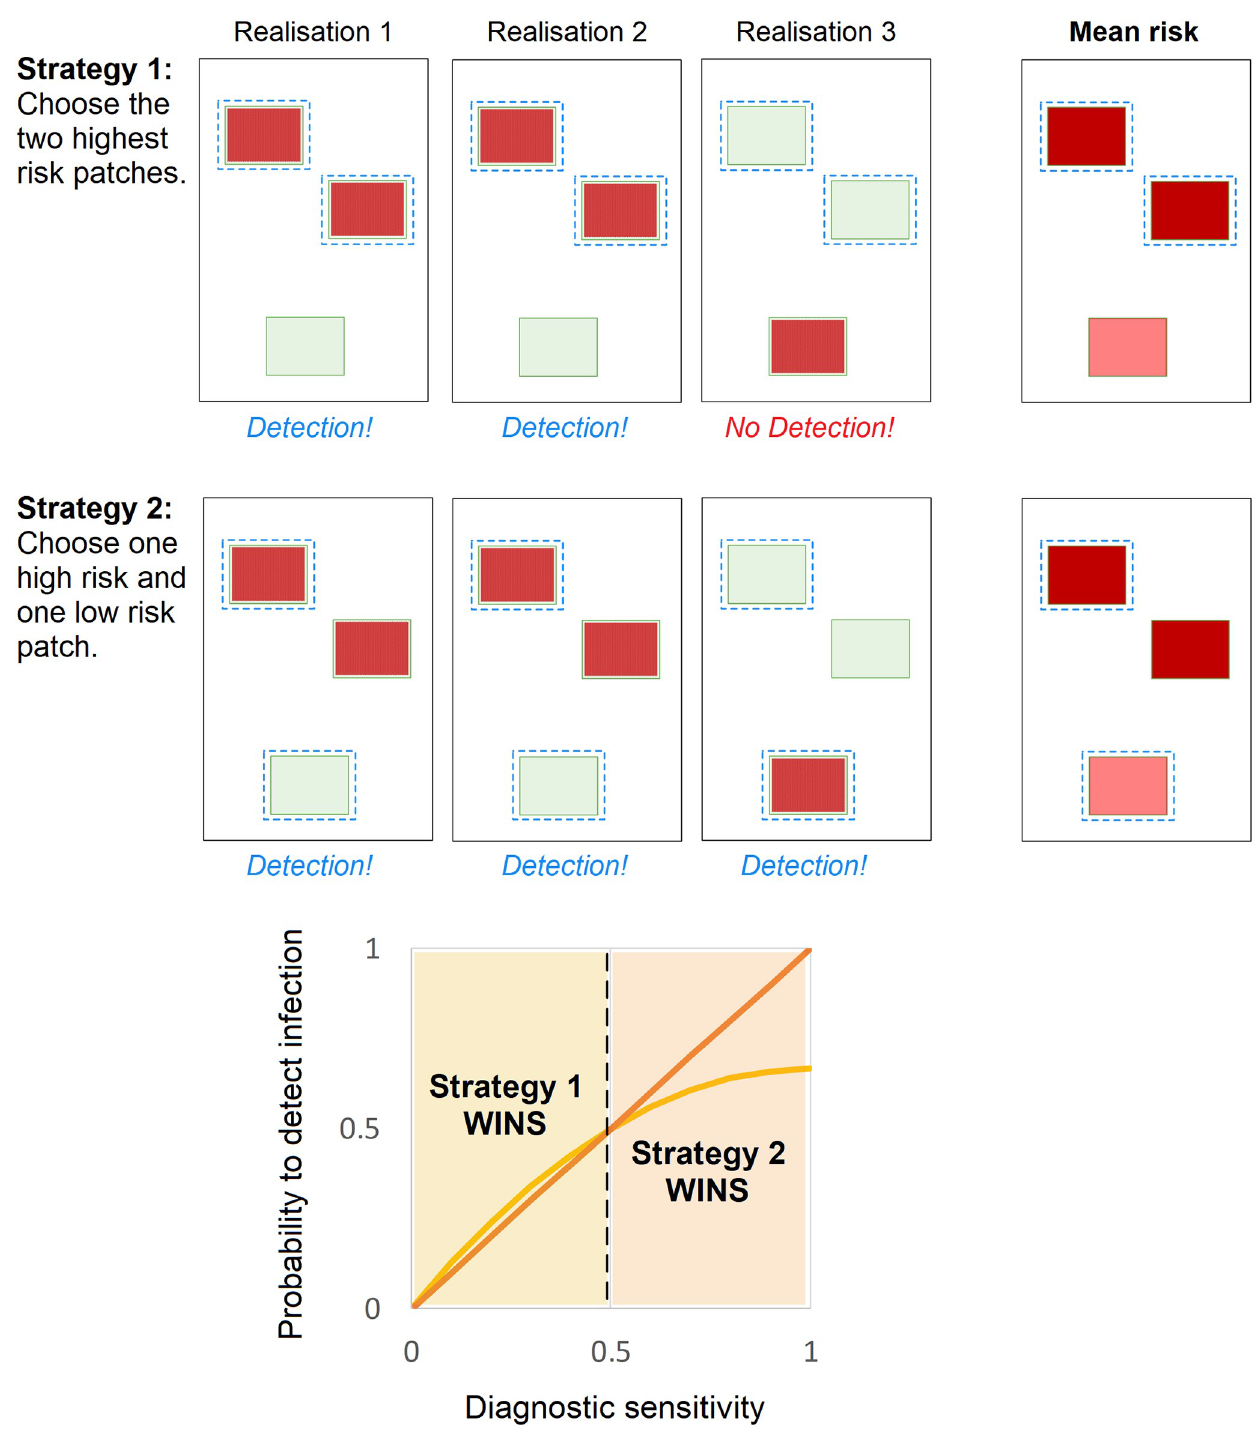
Fig 7. Maximising the probability to detect a pathogen is achieved not by selecting the highest-risk patches, but by spreading surveillance across all clusters of risk. For ease of communication, we consider patch status as a dichotomous variable (which can be infected, shown in red, or uninfected, shown in green), rather than considering dynamic trends over time. We wish to sample the 2 patches that maximise the probability of detecting infection over all realisations (selected patches are shown with a blue dashed outline). The 2 ‘strategy’ diagrams on the top each show 3 possible realisations of patch infection status, with the status of the upper 2 host patches correlated due to their proximity. We consider 2 selection strategies: one in which patches are selected based on their mean risk (Strategy 1) and one in which only one high-risk patch is selected and the remaining resources placed in the low risk patch (Strategy 2). If our detection method is perfect, we demonstrate that Strategy 2 outperforms Strategy 1 (being able to detect infection in each of the 3 realisations). The plot on the bottom shows how this is affected by the ability to detect infection in the patch (that is, the diagnostic sensitivity), with the detection probability under Strategy 1 shown in orange and that under Strategy 2 shown in red, for all sensitivity estimates between 0 and 1. In this particular example, the mean